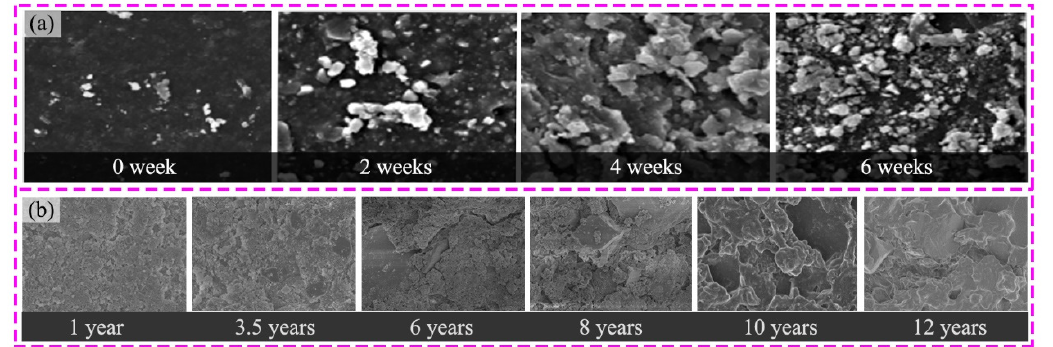
Figure 8. Comparison of aging composite insulators under scanning electron microscope. ( a ) SEM image of composite insulator after aging for 0 weeks, 2 weeks, 4 weeks, and 6 weeks. ( b ) SEM image of composite insulator after aging for 1 year, 3.5 years, 6 years, 8 years, 10 years and 12 years.